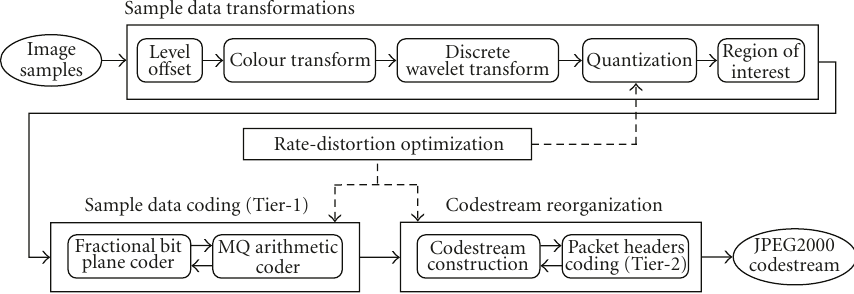
Figure 1: Stages and operations of the JPEG2000 core coding